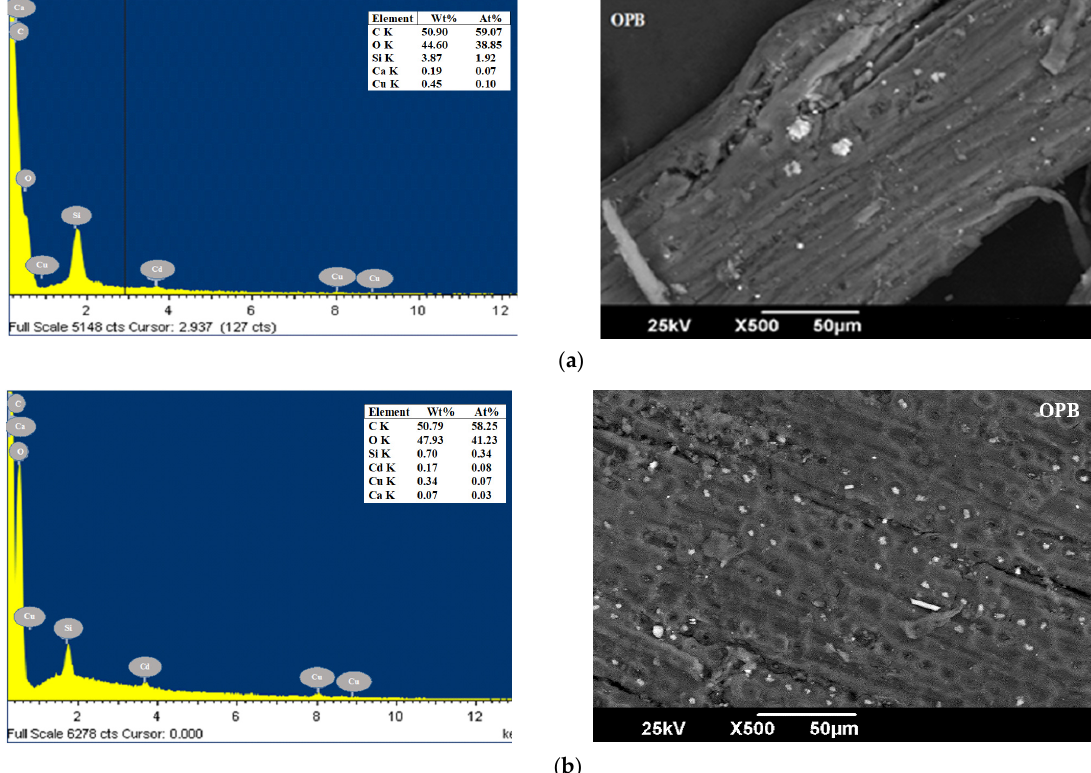
Figure 2. EDS spectra and -SEM micrographies for r OPB: ( a ) before and ( b ) after adsorption.